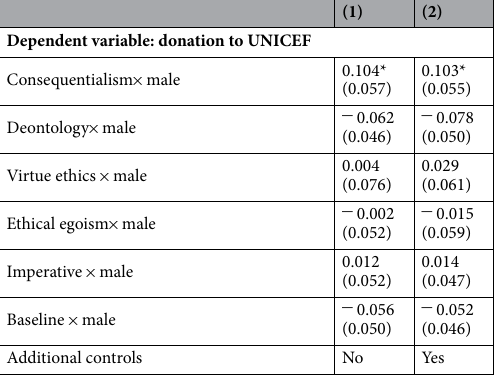
Table 2. Gender differences in the effects of messages. Coefficients from OLS models (standard errors in parentheses) and controlling for the date of data collection. Additional controls are age, ethnicity, political view, moral conviction and the five MFQ moral values. * p < 0.1 ; ** p < 0.05 , *** p < 0.01